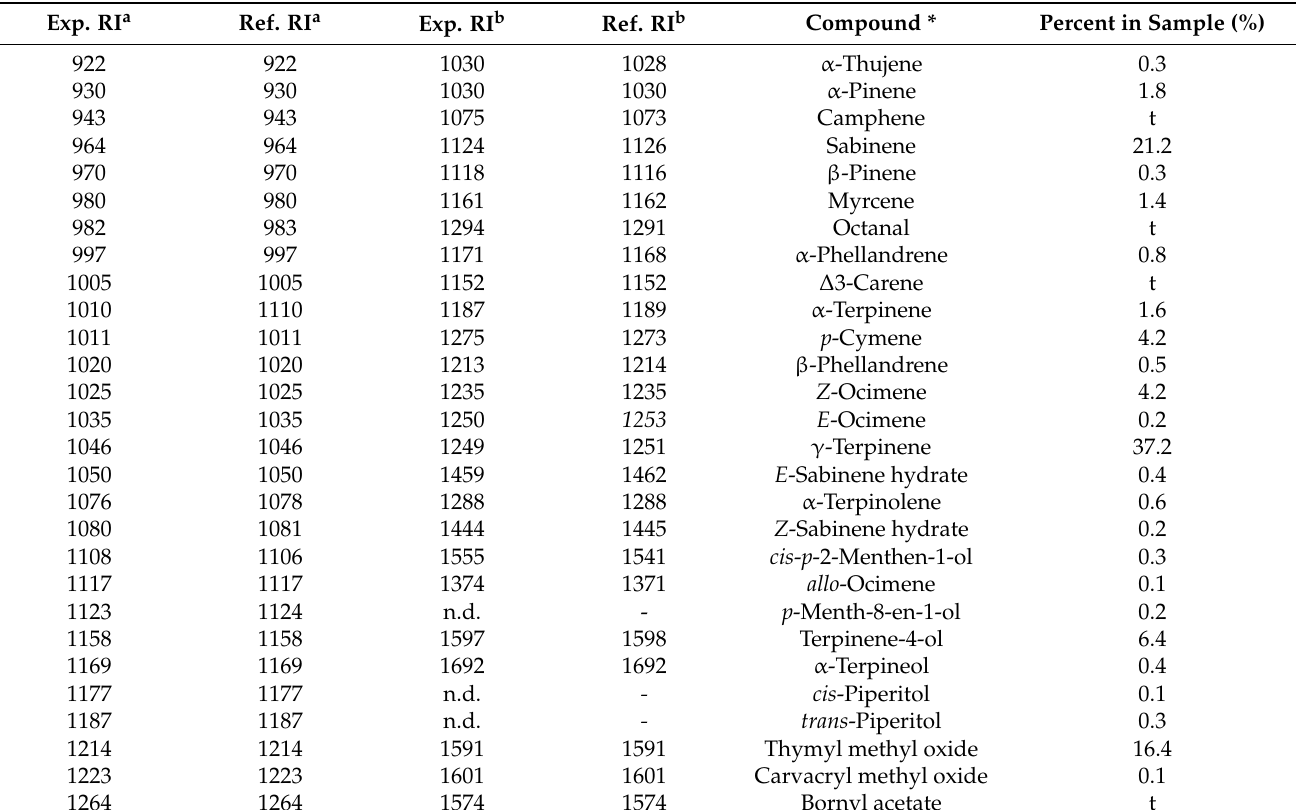
Table 2. Composition of essential oil from Crithmum maritimum